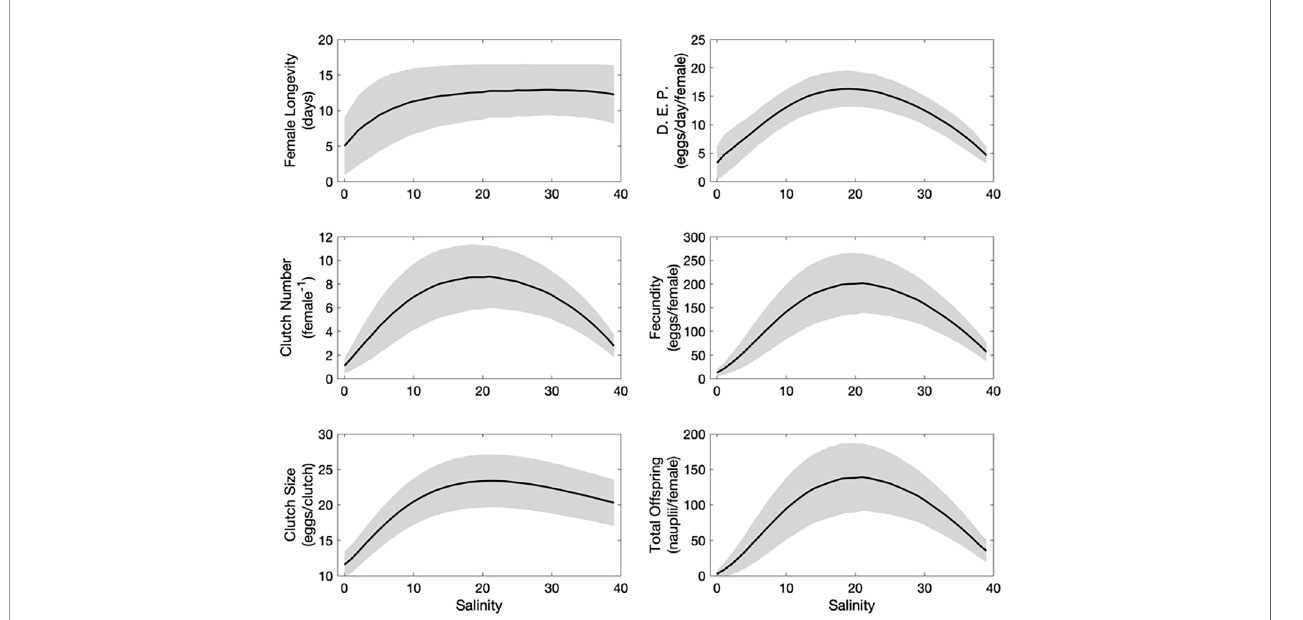
FIGURE 5 | Average (black line) and standard deviation (gray area) of different reproductive traits (Left: female longevity, clutch number, clutch size) and the resulting individual production (right: daily egg production, total egg production, total offspring production) for 15,000 females (15 runs of 1000) exposed to different